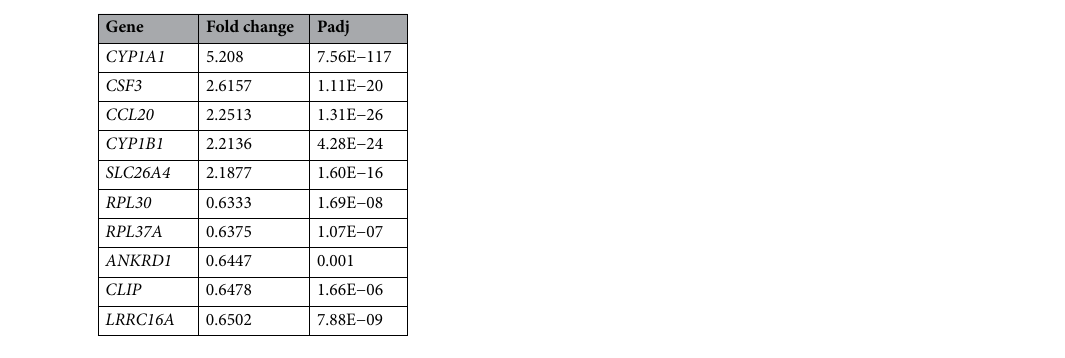
Table 2. Differentially regulated genes in NHBE cells exposed to e-cig smoke